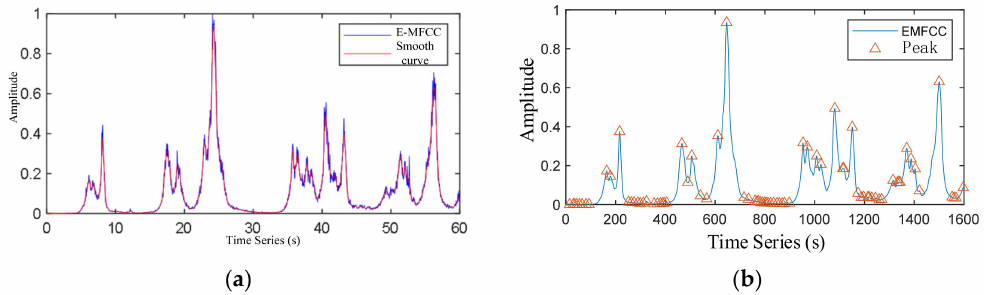
Figure 7. E-MFCC characteristic curve and extremum extraction. ( a ) E-MFCC characteristic curve and its smoothed characteristic curve and ( b ) E-MFCC extremum